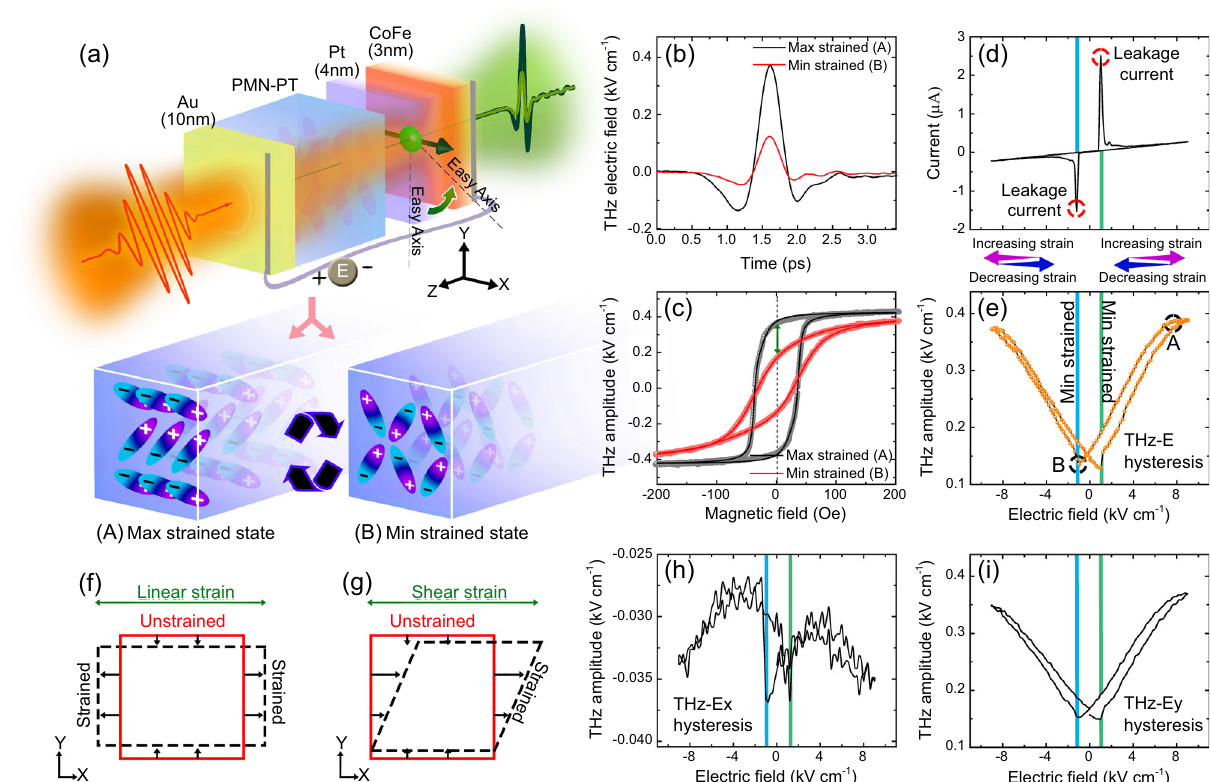
Fig. 1 Electric fi eld tunable THz spintronic emitter. a Image depicts the design of THz spintronic emitter, as used for the experiment, Laser beam (0.4 mJ cm -2 )/ Au(10 nm)/ PMNPT(1 mm)/ Pt(4 nm)/ Co 75 Fe 25 (3 nm). PMNPT(011) is used as the ferroelectric material where the electric dipoles align in the (i) out-of-plane direction under maximum strained state and (ii) in-plane direction under minimum strained state. Upon strain transfer from the FE layer, the easy axis of the FM layer rotates as shown by the green arrow. b THz pulse as obtained from the emitter under two extreme strained states, A (max) and B (min) at H = 0 Oe . c THz-H hysteresis 51 curves of the emitter under two extreme strained states. The green arrow highlights the observed change in the THz spin current at H = 0 Oe . The double Langevin model 61 was used to fi t the obtained THz-H hysteresis. d I-V characteristic shows the fl ow of leakage current from the substrate when sweeping the electric fi eld between 9 kV cm − 1 and − 9 kV cm − 1 at H = 0 Oe . The position of leakage current identi fi es the electric fi eld coercivity in PMNPT, E cr = ±1.2 kV cm − 1 . The blue line depicts negative E cr , and the green line depicts positive E cr e THz-E hysteresis curves as observed upon recording the THz pulse amplitude at H = 0 Oe while sweeping the electric fi eld between 9 kV cm − 1 to − 9 kV cm − 1 . f , g illustration of the two possible states of strain in the PMNPT as a result of applied electric fi eld. f Linear strain g Shear strain h X-component of the THz- E hysteresis upon sweeping the electric fi eld between 9 kVcm − 1 to − 9 kV cm − 1 at H = 0 Oe i Y-component of the THz-E hysteresis upon sweeping